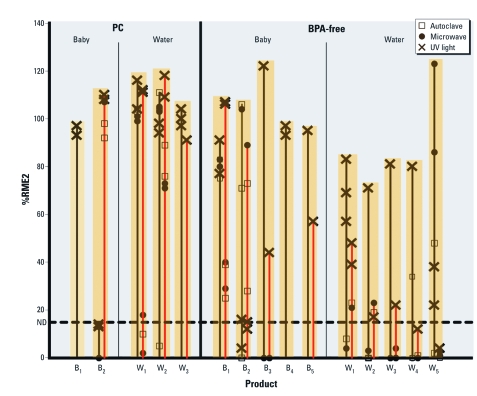
Total EA released by some PC and BPA-free water bottles (W) and
baby bottles (B). The leaching of chemicals having EA (measured as %RME2; excluding
caps, nipples, and other components) were extracted using saline or EtOH as solvents
and exposed to autoclaving, microwaving, and/or UV light (see “Materials and
Methods” for details). BPA-free water bottles W1, W2,
W3, and W4 are PETG, and W5 is PET. BPA-free
baby bottles B1 and B2 are polyethersulfone; B3 is
PETG; and B4 and B5 are PP. Orange bars indicate the data set
for each individual product. The %RME2 for saline extracts is represented by solid
black lines and for EtOH as solid red lines. Symbols represent the %RME2 of
chemicals released by each assay of a product after an autoclaving stress,
microwaving stress, and UV light stress (see figure key). The dotted horizontal line
at 15% RME2 is the rather conservative value below which EA was considered
nondetectable (ND) for any assay. For some products shown (e.g., PC B1,
BPA-free B4), if one solvent and/or stress condition showed reliably
detectable EA, other solvents and stress conditions were not subsequently tested.
Some values plotted as 0% RME2 actually had slightly negative %RME2 values (–1% to
–7% RME2) due to cellular toxicity.